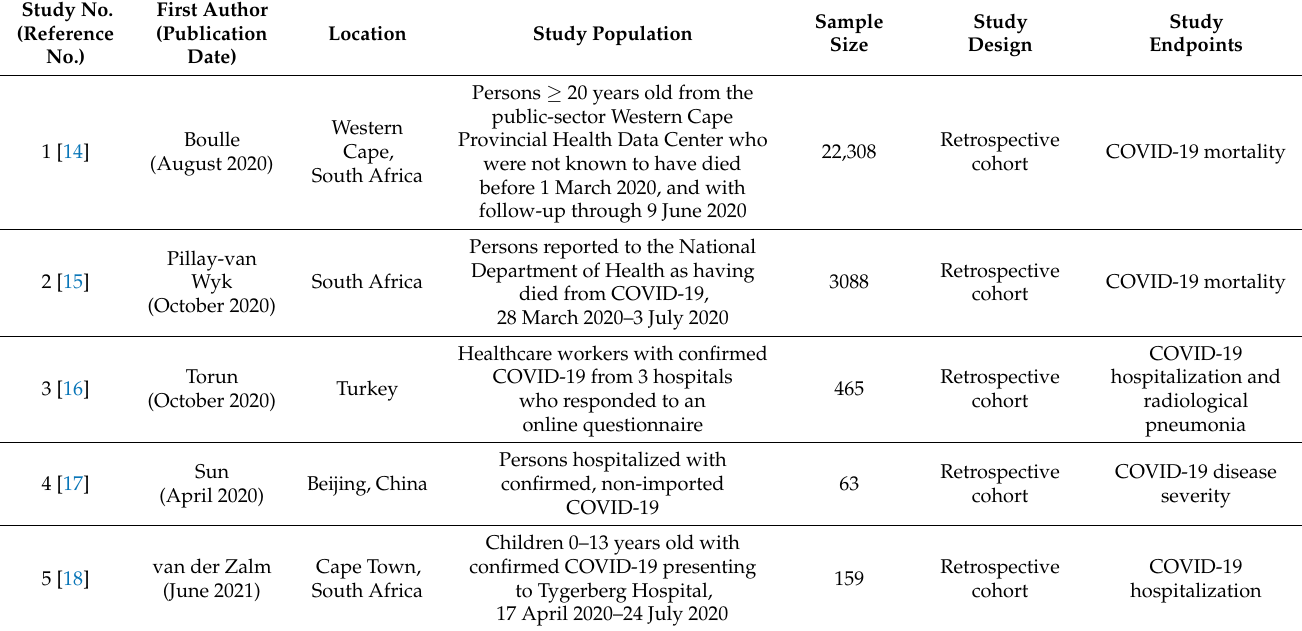
Figure 1. Selection of studies. Table 1. Characteristics of all included studies reporting on COVID ‐ 19 endpoints with TB as expo ‐ sure.